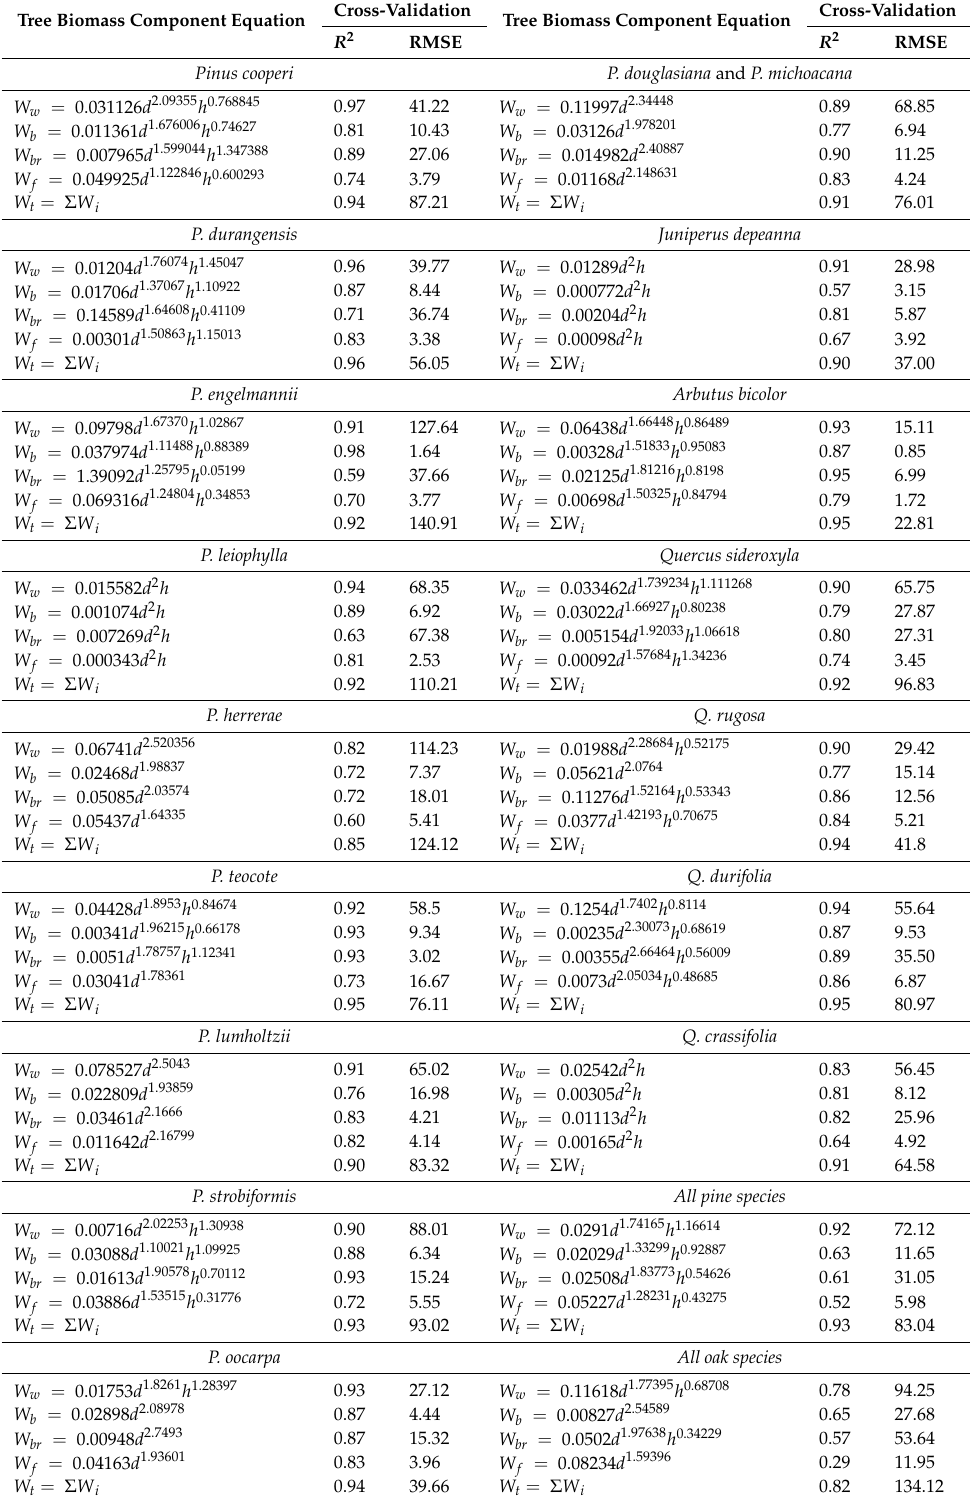
Table 2. Estimated parameters and goodness of fit statistics for the biomass equations for temperate forest species in Durango state,